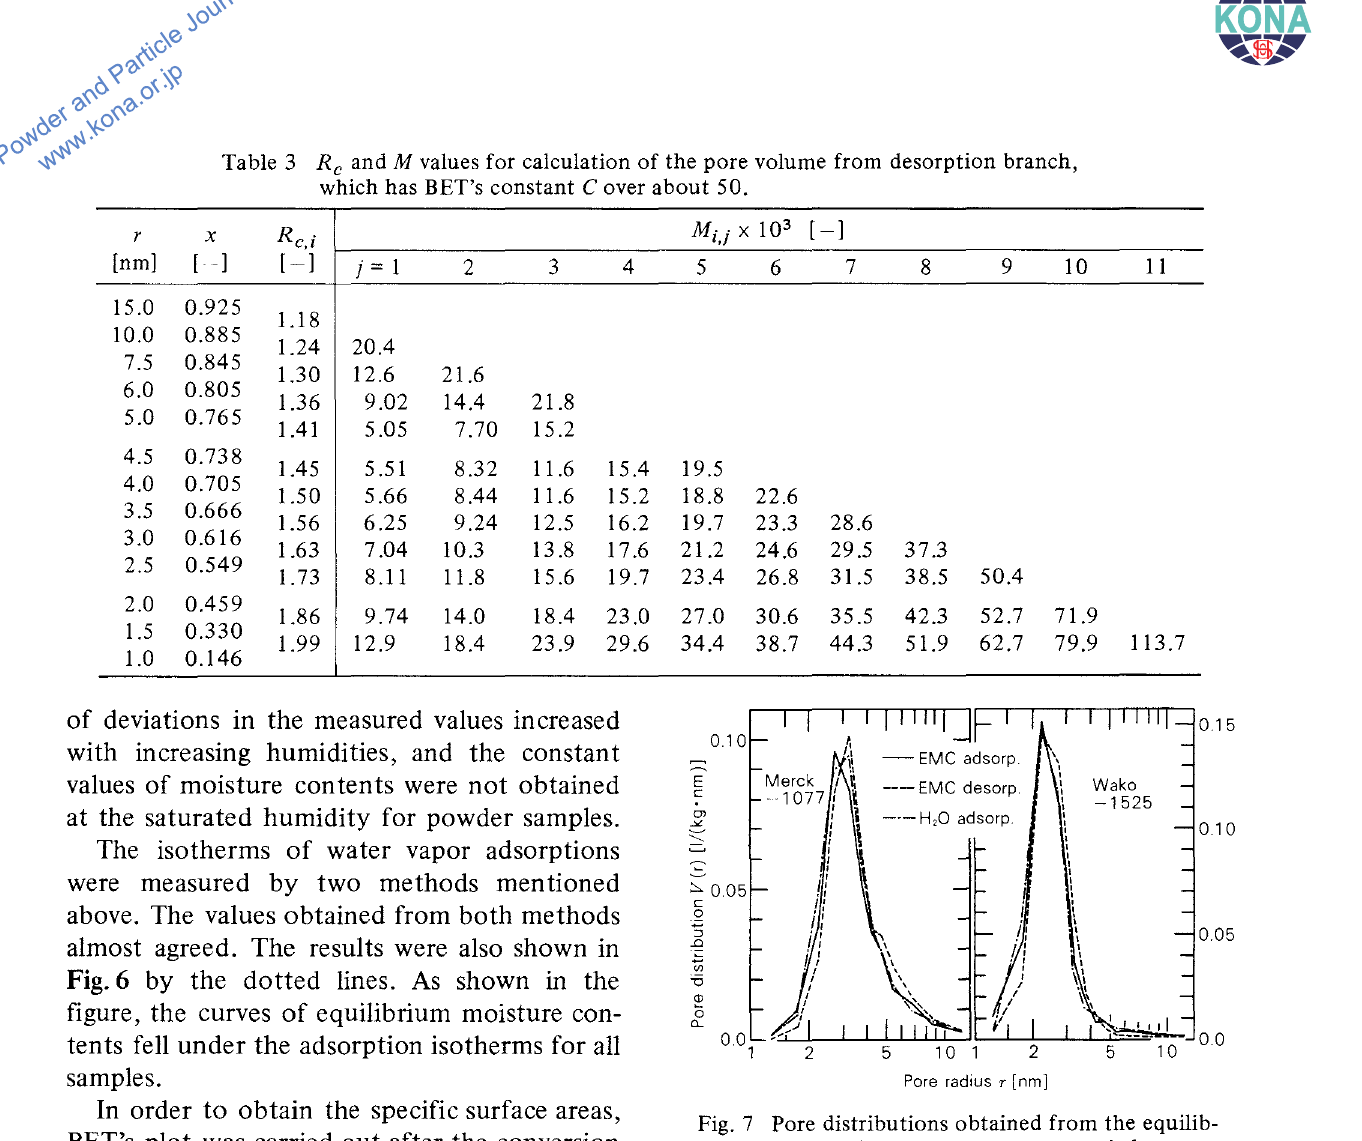
Fig. 7 Pore distributions obtained from the equilib rium moisture content curves and the water vapor adsorption